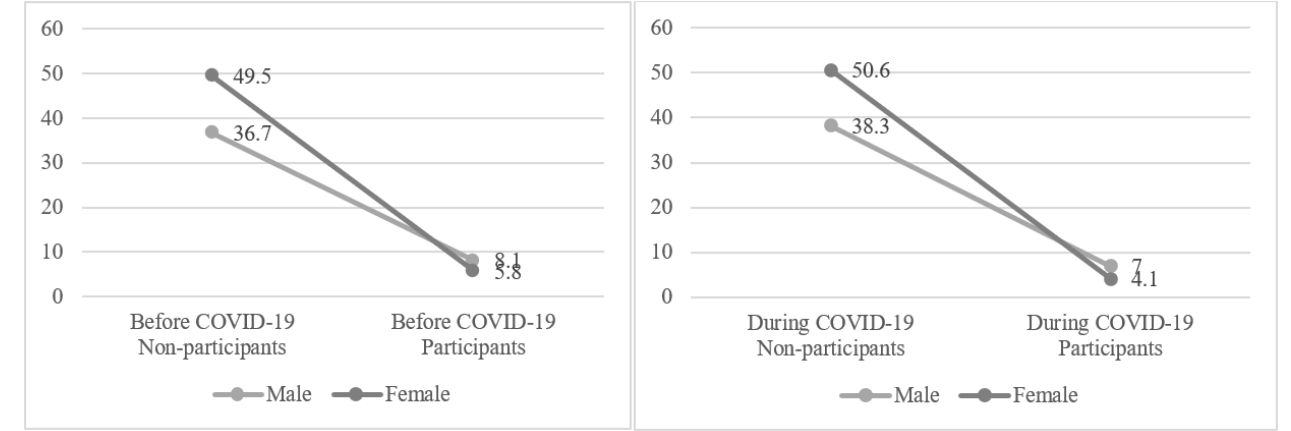
Figure 6. Changes in obesity by gender and regular PA before and during COVID-19. Note: Obesity